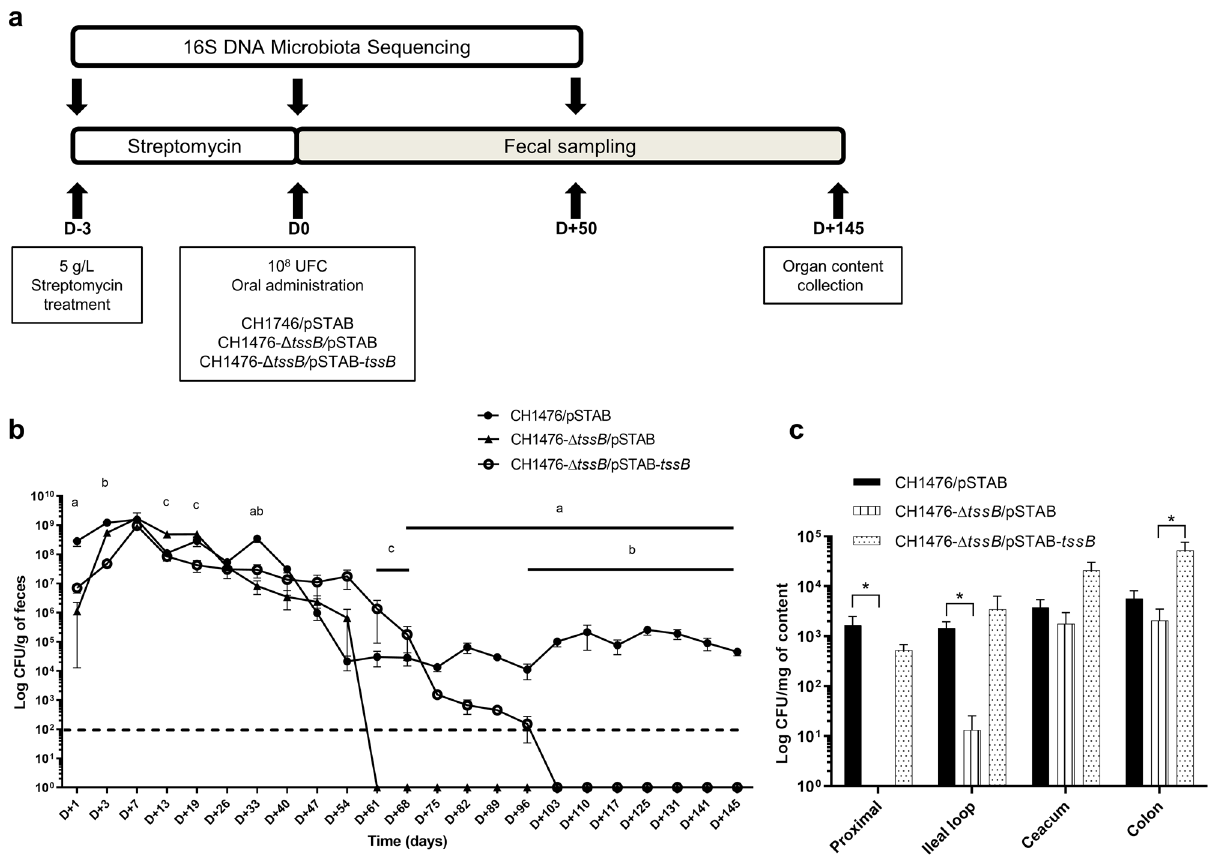
Figure 3. Role of T6SS-1 in gastrointestinal colonization of mice by K. pneumoniae CH1476. (a) Experimental procedure (n = 6/group). (b) After 72 h of streptomycin treatment (5 g/L in drinking water), mice were intragastrically inoculated with 1 × 10 8 CFU of K. pneumoniae CH1476 strain (CH1476/pSTAB, full circle), CH1476-Δ tssB isogenic mutant (CH1476-Δ tssB /pSTAB, full triangle) or the trans-complemented control strain (CH1476-Δ tssB /pSTAB- tssB , empty circle). Results are expressed as means K. pneumoniae CFU/g of feces ± SEM over 145 days; the dashed line indicates the limit of detection (10 2 CFU). Statistical analysis: nonparametric Kruskall-Wallis with Dunn’s multiple comparison test: a, b, c: p < 0.05, respectively CH1476/pSTAB vs CH1476- Δ tssB /pSTAB, CH1476/pSTAB vs CH1476-Δ tssB /pSTAB- tssB and CH1476-Δ tssB /pSTAB vs CH1476-Δ tssB / pSTAB- tssB . (c) Representation along the gastrointestinal tract of K. pneumoniae CH1476/pSTAB (black bar), CH1476-Δ tssB /pSTAB isogenic mutant (full line bar) or the CH1476-Δ tssB /pSTAB- tssB trans-complemented control strain (dotted line bar) in CFU/g of content in mice. Data are expressed as means of each 6 values ± SEM. Statistical analysis: nonparametric Kruskall-Wallis with Dunn’s multiple comparison test: * P < and 145 days post-infection, respectively. Analysis of the intestinal content of the three sets of mice on day 145 post-infection showed that CH1476-Δ tssB /pSTAB was mainly present in the lower part of the gastrointestinal tract, whereas the CH1476/pSTAB WT and the trans-complemented strains were detected at similar levels in the proximal intestine and the colon (between 10 3 and 10 4 CFU/g of content) (Fig. 3c). Similar results were obtained with the CH1476-Δ clpV mutant, which is deficient in T6SS recycling. CH1476-Δ clpV strain colonization levels were significantly lower than those of the CH1476 parental strain 80 days after infection (3.1.10 4 CFU/g of feces